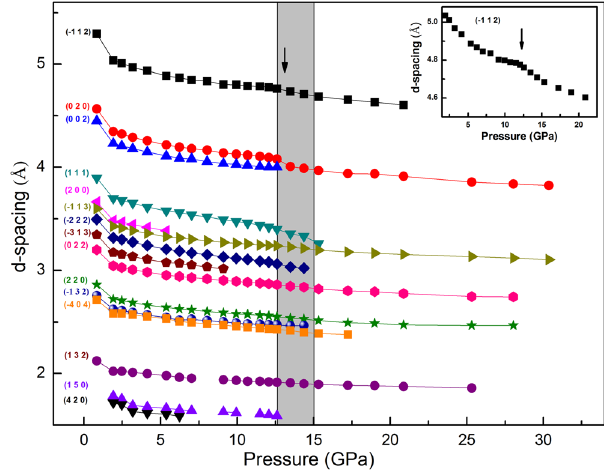
Figure 4. Pressure-dependence of the d -spacings from 0.8–30.7 GPa.